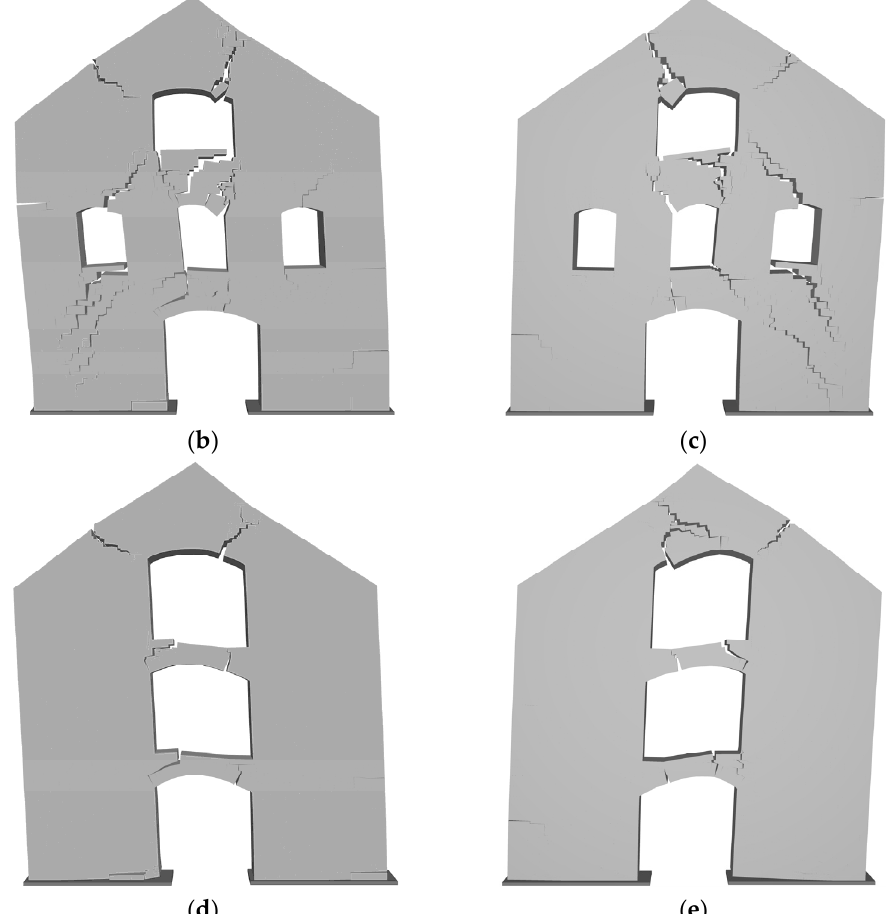
Figure 9. ( a ) Pushover curves for North and South Facades of the Bytown Building and associated collapse mechanisms, respectively; ( b – d ) Right to Left (R-L); ( c – e ) Left to Right (L–F).